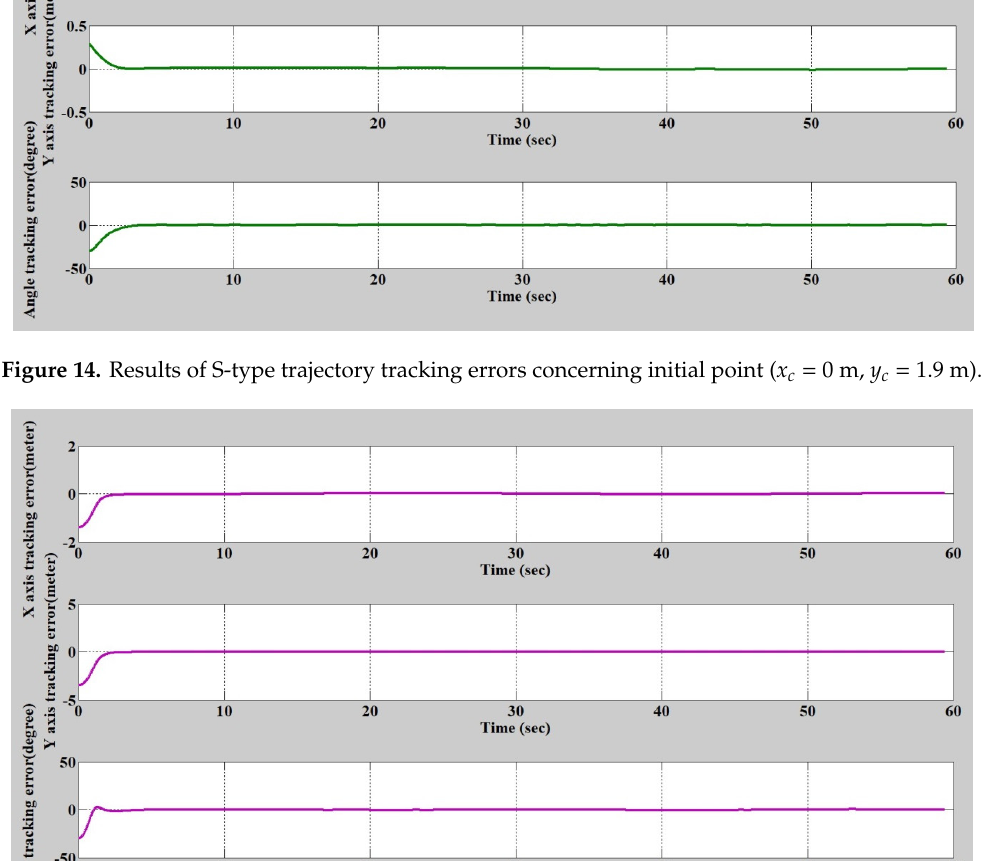
Figure 15. Results of S-type trajectory tracking errors concerning initial point ( x c = 0 m, y c = − 1.9 m).